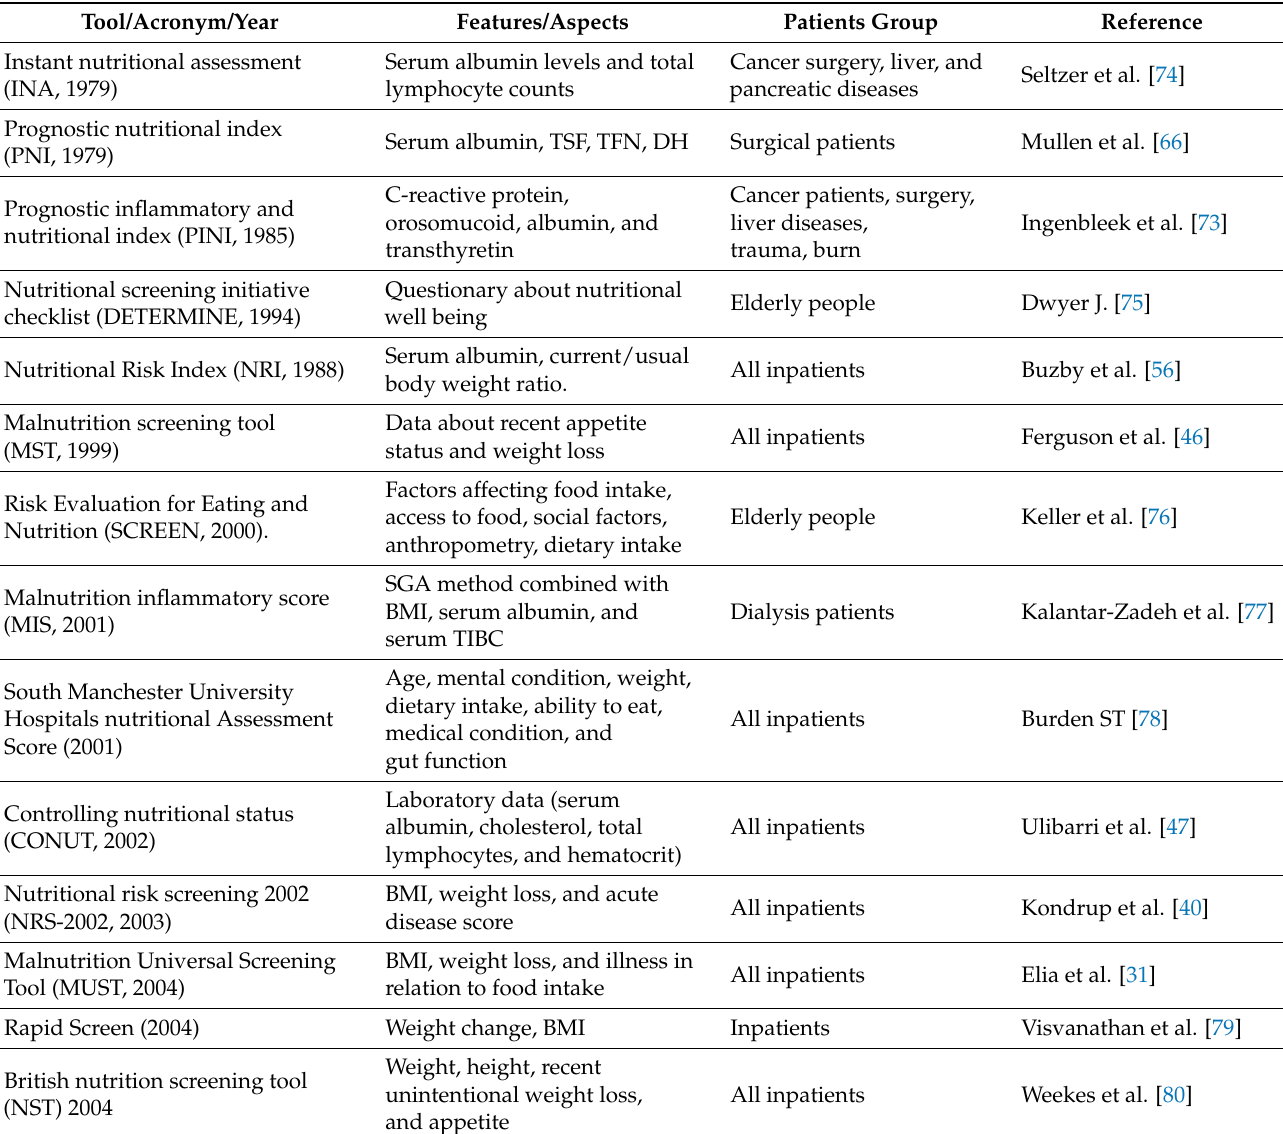
Table 5. Nutritional Screening